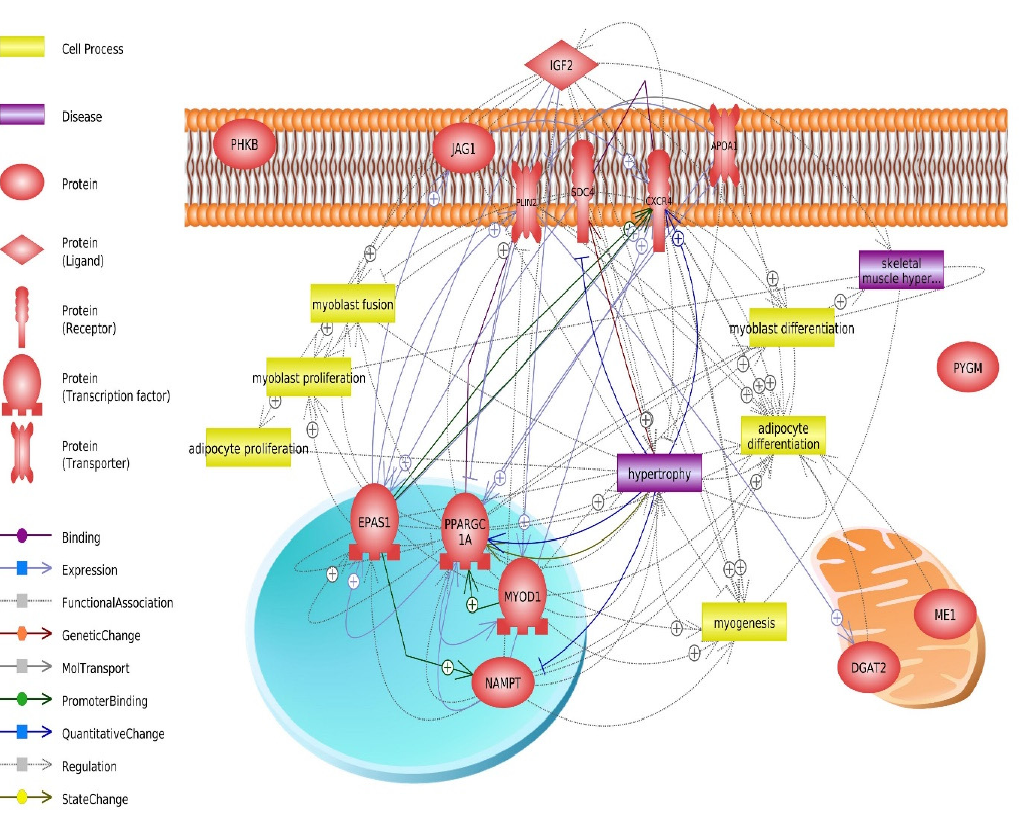
Figure 3. Pathway studio visualization of gene relevance network.